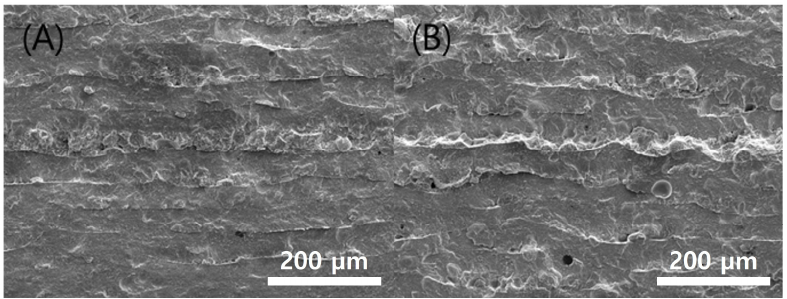
Figure 9. Cross-sectional SEM images green body specimens according to various chamber temps: ( A ) 40 ◦ C; ( B ) 60 ◦ C. Sintering was performed on the green body specimen, which was obtained by the normal completion of printing at the chamber temperatures of 40 ◦ C and 60 ◦ C. No